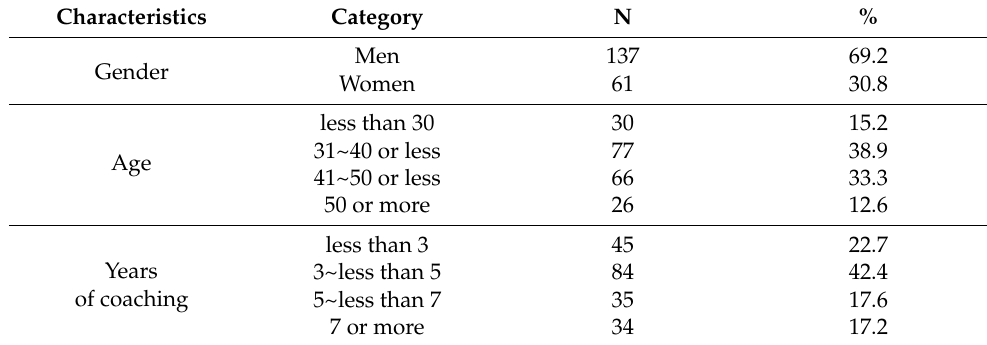
Table 1. Characteristics of the